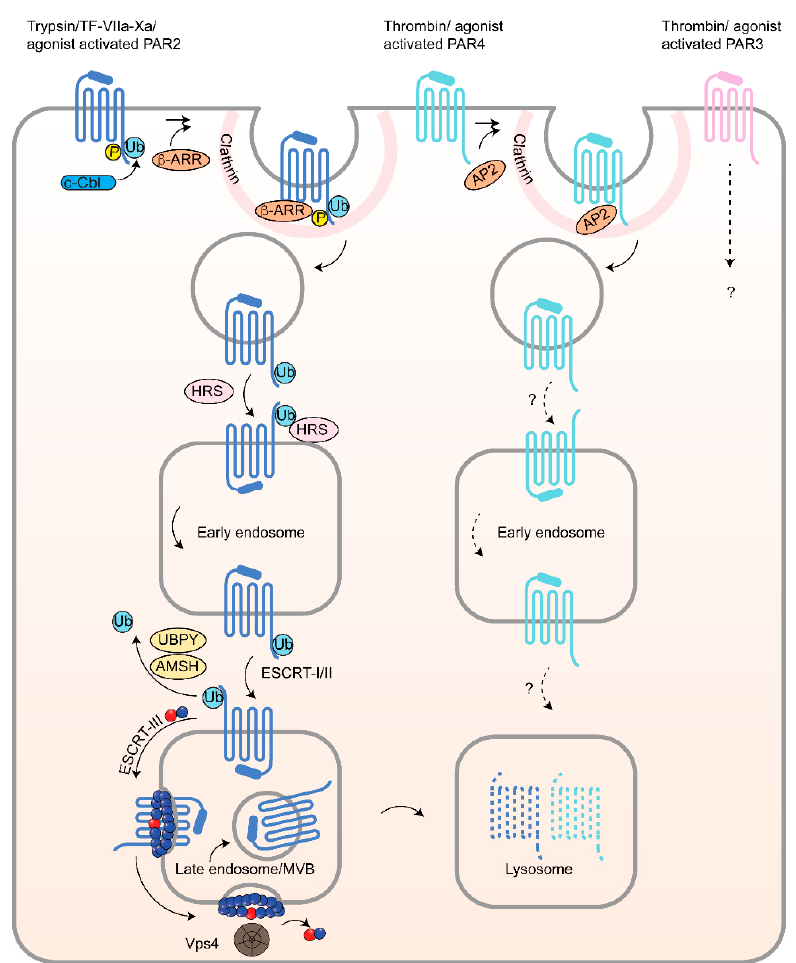
Figure 5. Endocytic trafficking of PAR2, PAR3 and PAR4. Agonist-activation of PAR2 can occur by trypsin, tissue factor (TF)-VIIa-Xa or peptide agonist SLIGKV and induces phosphorylation and ubiquitination followed by receptor internalization, which is mediated by β -arrestins ( β -ARR) through a clathrin- dependent pathway. Ubiquitination of activated PAR2 by the E3 ubiquitin ligase c-Cbl, functions primarily in PAR2 endosomal-lysosomal trafficking. Ubiquitinated PAR2 is recognized by HRS at early endosomes and required for lysosomal sorting, after deubiquitination mediated by the AMSH and UBPY deubiquitinating enzymes that enable sorting of PAR2 to MVBs by the ESCRT-III/Vps4 machinery and ultimately degradation. Agonist-activation of PAR4 by thrombin or AYPGKF induces internalization mediated by AP-2 and occurs through a clathrin-dependent pathway similar to PAR1. AP-2 binds activated PAR4 by recognizing a tyrosine-based sorting motif present in the third intracellular loop of the receptor. Internalized PAR4 is then sorted to endosomes and lysosomes for degradation. The endocytic adaptor proteins that facilitate PAR4 endosomal-lysosomal trafficking are unknown. The mechanisms that control thrombin-activated PAR3 internalization and trafficking to lysosomes is not known.